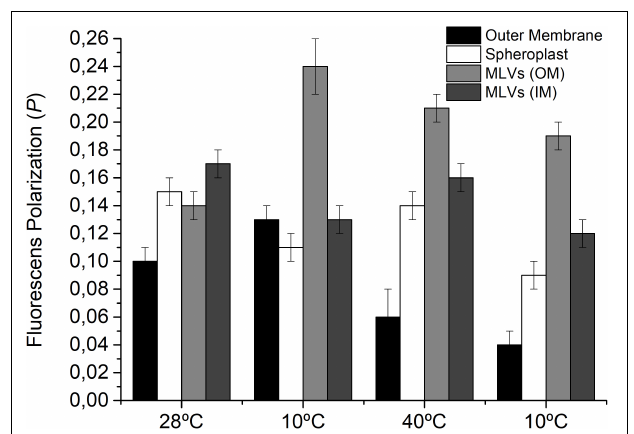
FIGURE 5 | Fluorescence polarization of DPH in IM (spheroplast) and OM as well as in MLVs of lipids extracted from S. meliloti OM and IM after each temperature change. S. meliloti culture (200 mL) was grown to a stationary phase at 28 ◦ C and then the thermal changes applied (10 ◦ C–40 ◦ C–10 ◦ C) for 24 h incubation periods. After exposure to each temperature, one aliquot (50 mL) was separated, and OM and IM fractions were obtained. MLVs were prepared from lipids obtained of OM and IM. The fluorescent membrane probe (DPH) 4 µ mol L − 1 was added to the membranes and MLVs suspension (3 mL) and incubated to facilitate incorporation of the probe. Fluorescence polarization was measured at 25 ◦ C. Values are the mean ± sd of three independent